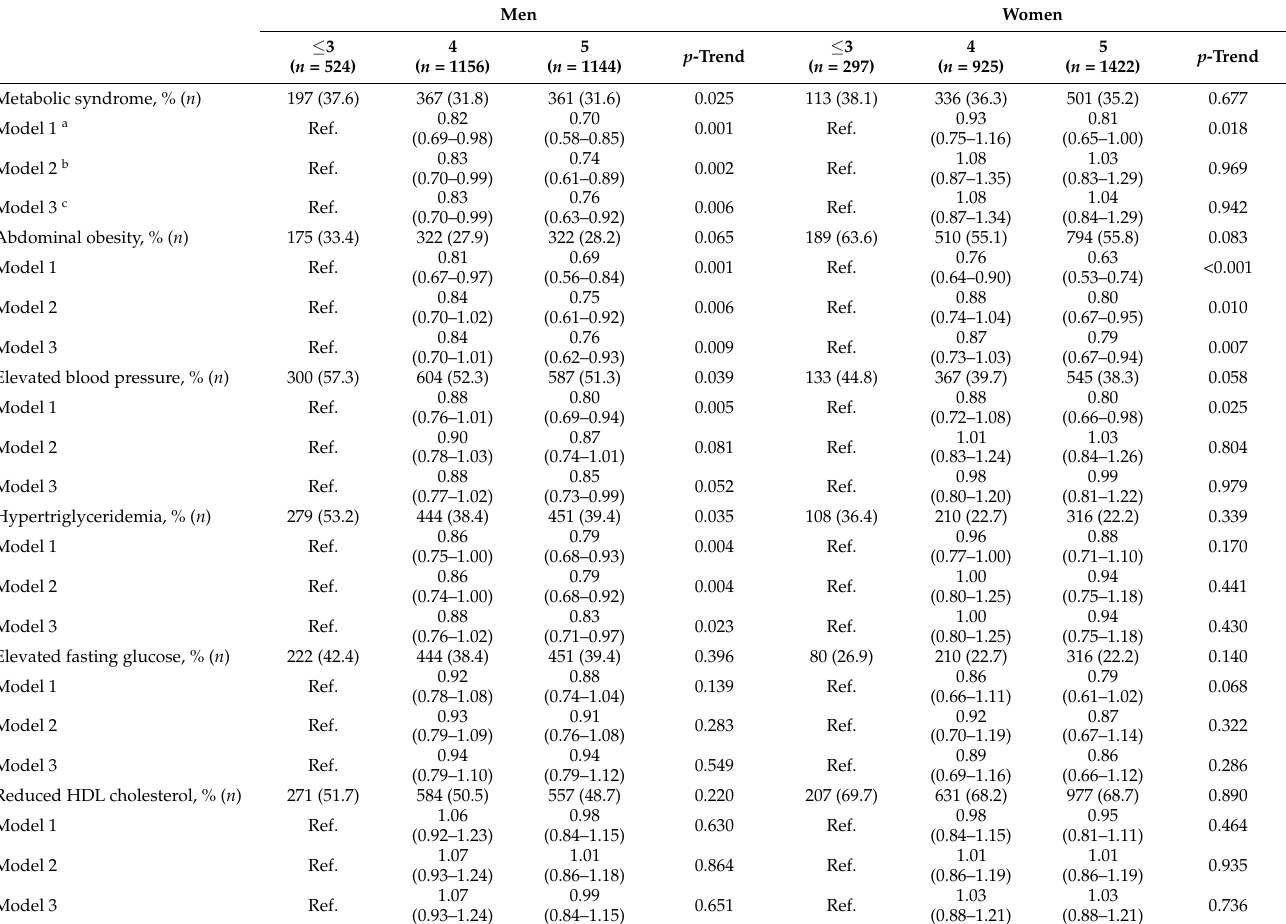
Table 4. Hazard ratios (HRs) and 95% confidence intervals (CIs) for the risk of metabolic syndrome and its components according to dietary diversity